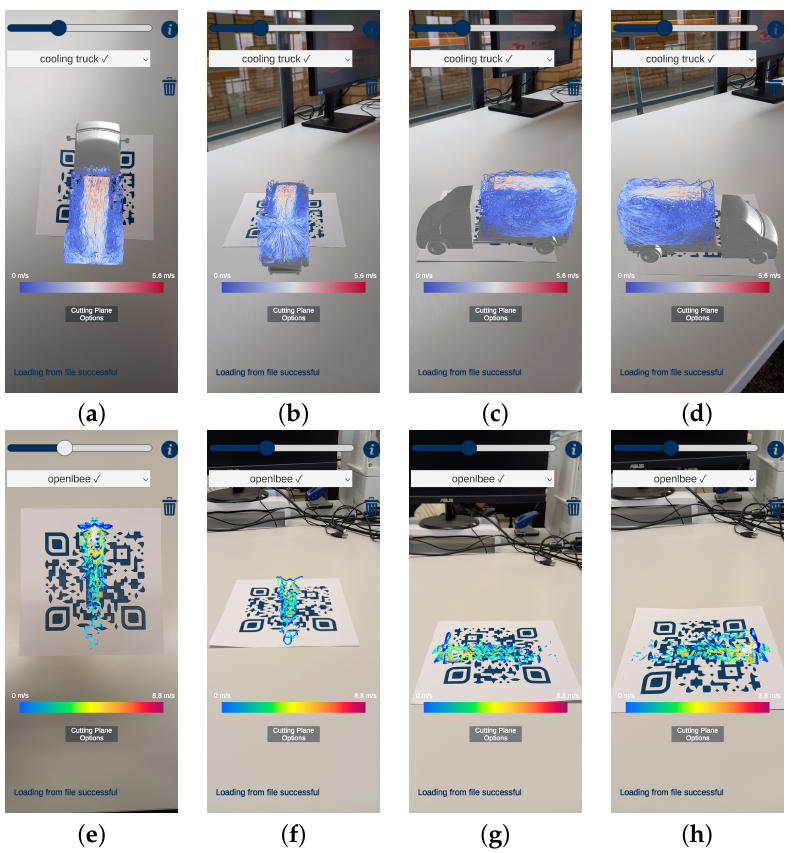
Figure 22. Viewing the results on the QR code from different angles. Figure 22a–d show this using the cooling truck and Figure 22e–h using the bee. ( a ) Cooling truck top down view. ( b ) Cooling truck back side view. ( c ) Cooling truck left side view. ( d ) Cooling truck right side view. ( e ) OLBee top